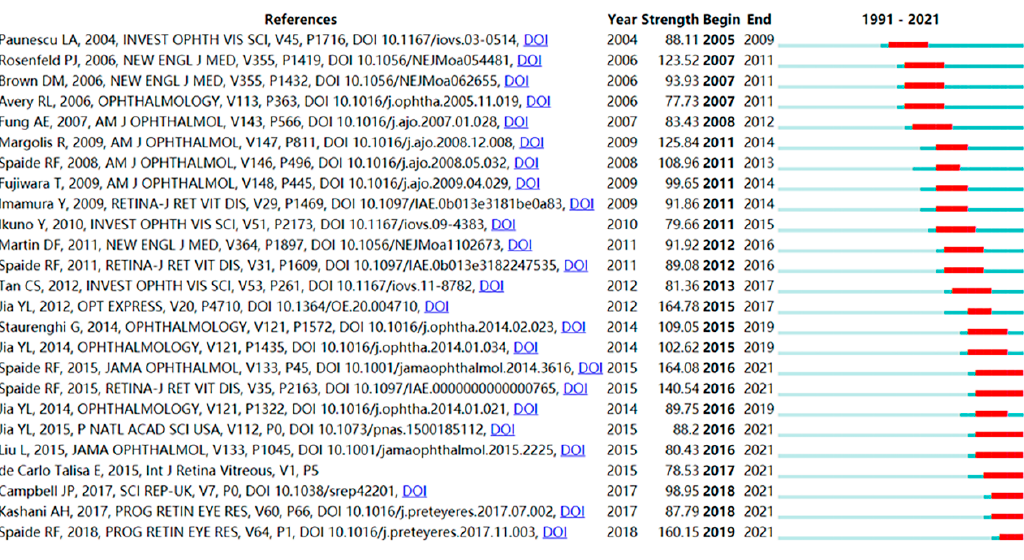
Figure 4. Top 25 references with the strongest citation bursts [4,6,7,14,15,18–36].